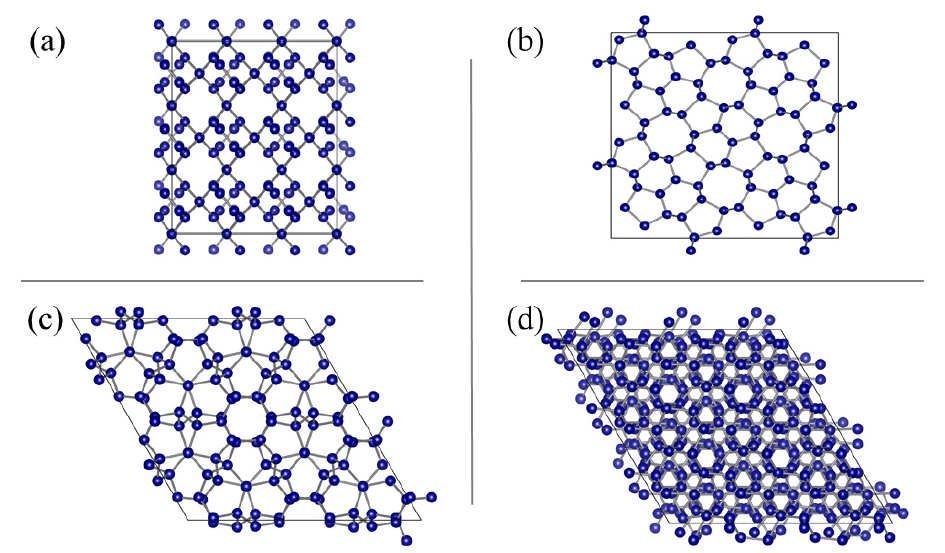
Figure 1. 2 × 2 unit cell structures of ( a ) 135-3-40-C-r89-np-id355667 with pure sp 2 hybridization, ( b ) 136-3-20-C-r689- np-id545421_1 with hybrid sp 2 /sp 3 hybridization, ( c ) 179-3-36-C-r6789-p-id545421 with pure sp 3 hybridization, and ( d ) 165-3-28-C-r68-np-id545421 with pure sp 3 hybridization. Table 1. Some representative carbon allotropes with different hybridizations.